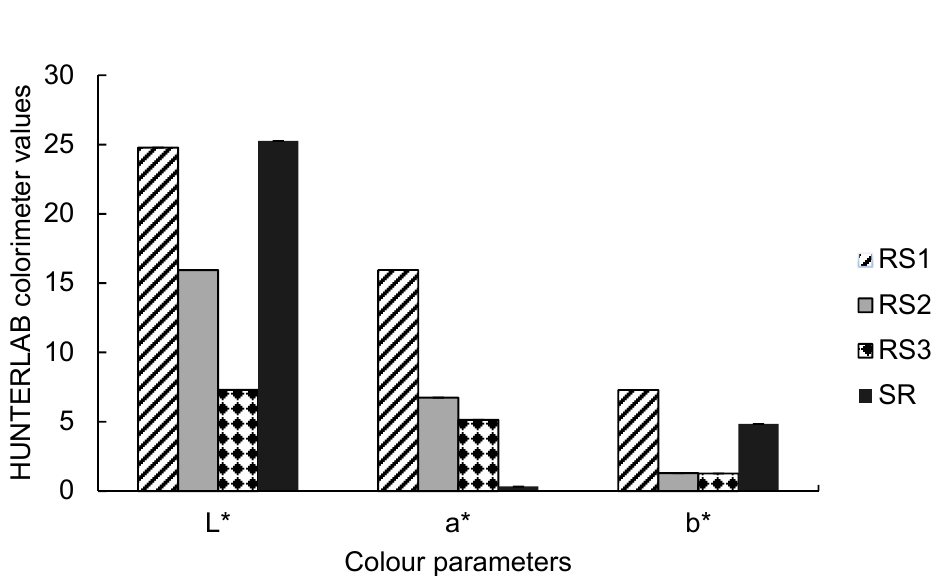
Figure 2. CIELAB colour properties of Carissa edulis fruit samples. RS1, first stage of ripening of C. edulis ; RS2, second stage of ripening of C. edulis berries; RS3, third stage of ripening of C. edulis berries; SR, standard reference sample (commercial blueberries); L*, lightness of samples; a* , redness when positive and greenness when negative; b* , yellow when positive and blue when negative. Error bars are standard deviation of mean values ( n = 3).